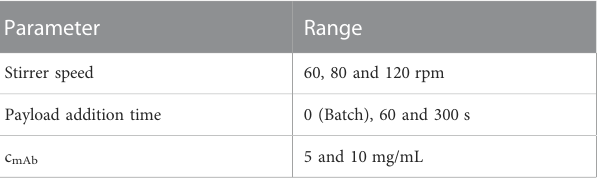
TABLE 2 Investigated process parameters within the parameter study conductedfortheGST-2.Standardconditionswere60 rpm,60 sadditiontime, 5 mg/mL mAb and 5x molar payload